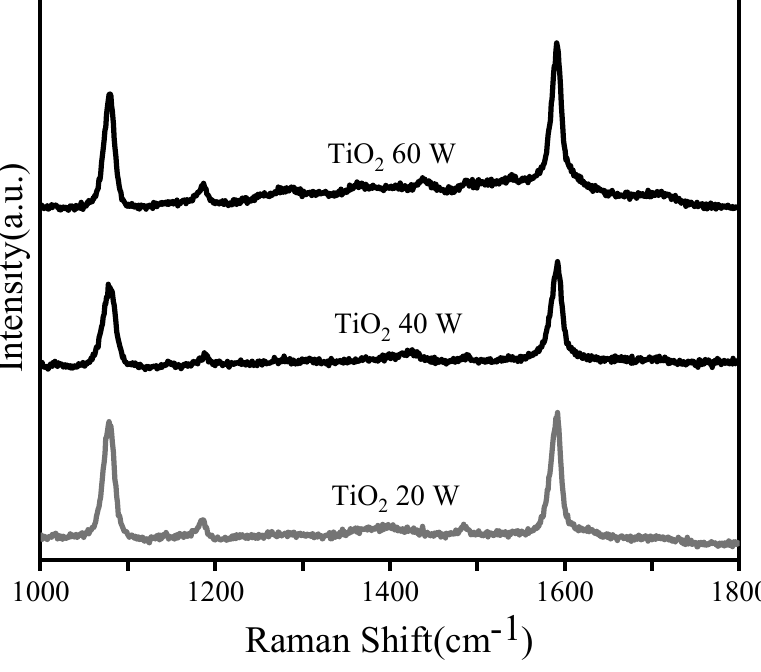
Figure 4. SERS spectra for the 4-MBA probe molecules absorbed on the composite TiO 2 -Ag with Ag sputtering power 10 W and TiO 2 sputtering powers 20 W, 40 W and 60 W.